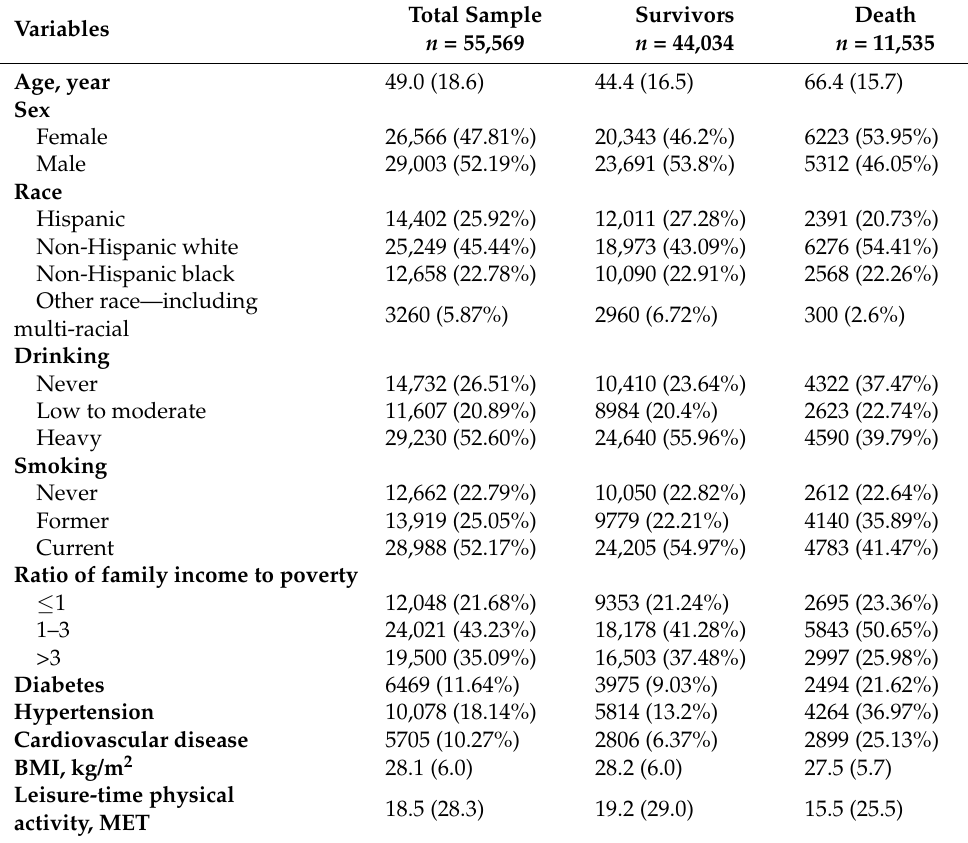
Table 1. Baseline characteristics of the study